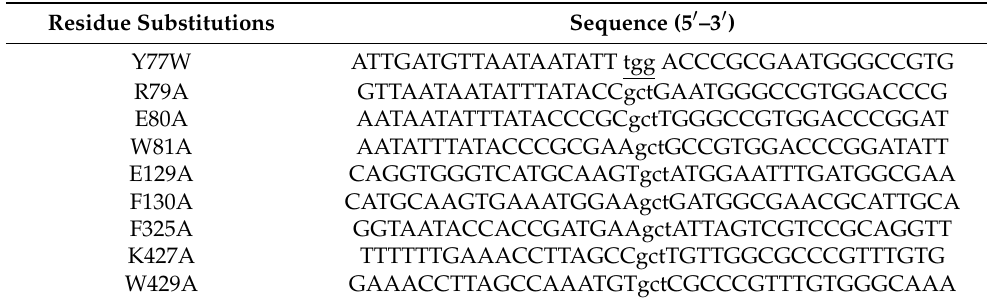
Table 1. Oligonucleotides used for